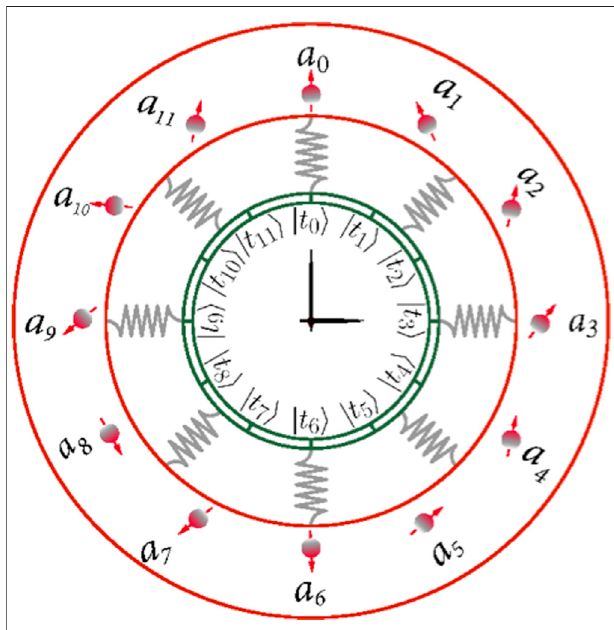
FIGURE 1 | System observables correlated with the clock